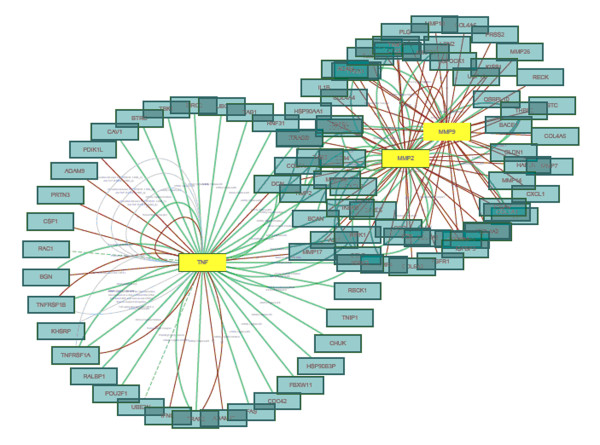
Illustration and visualization of the interactome network (Circle Layout). Drugs and proteins are linked as per the known drug-target network. Discrete network map with a customized visual Cytoscape Web style. Yellow nodes refer to the significant ontologies of the target. This subnetwork represents a coregulated unit containing 99 nodes and 153 edges.